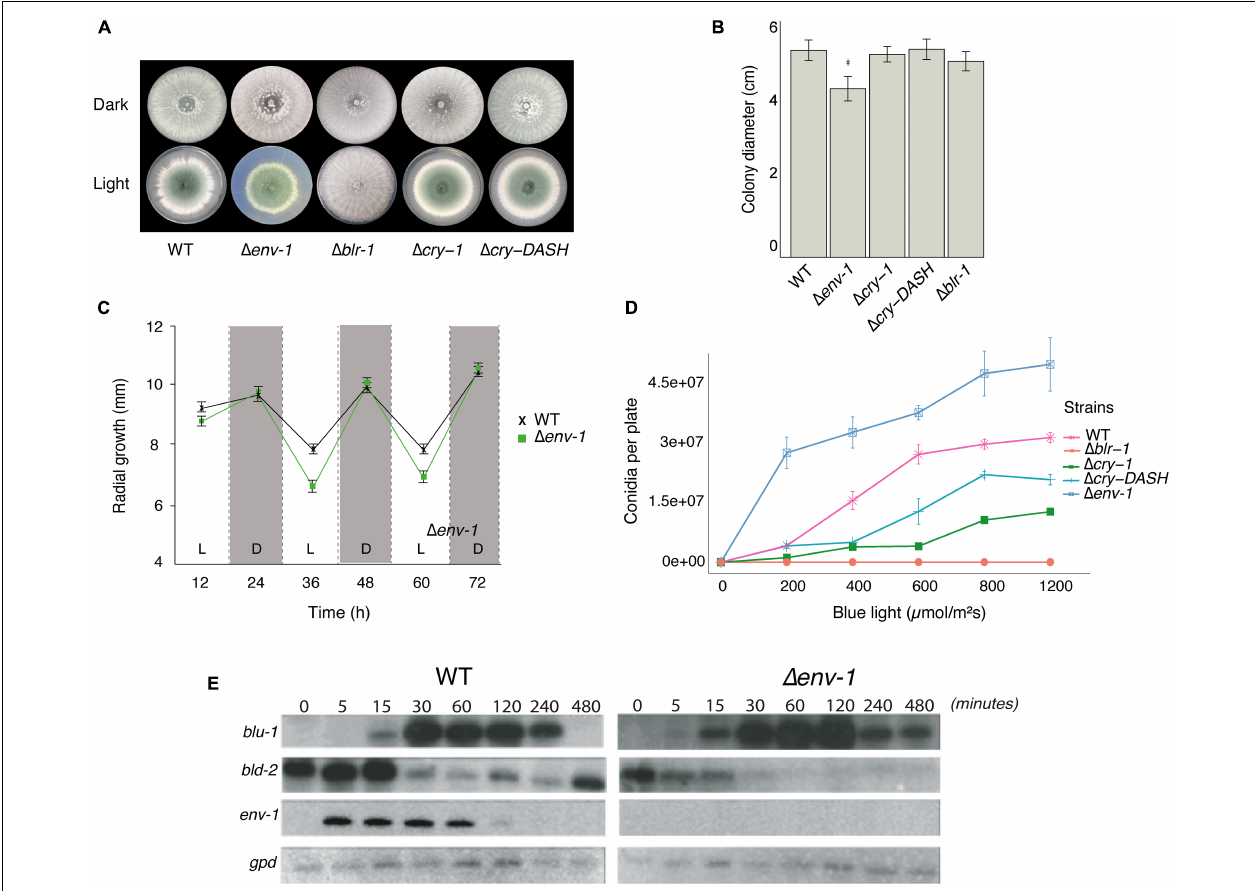
FIGURE 1 | Effect of light on growth and conidiation in the WT strain and the mutants (cid:49) blr -1, (cid:49) cry -1, (cid:49) cry-DASH and (cid:49) env -1. (A) Phenotype of the strains growing under darkness and constant light exposure. (B) Total growth of colonies under constant light exposure. Growth was measured every 12 h for 72 h under constant light and darkness on potato dextrose agar (PDA). (C) Radial growth of the WT and (cid:49) env -1 strains under 12-h light/dark cycles with 2.9 µ mol · m - 2 · s - 1 of blue light. (D) Production of conidia at different fluencies of blue light. The strains were grown for 36 h in the dark, then exposed to a pulse of blue light of 0, 200, 400, 600, 800, and 1,200 µ mol · m − 2 . Bars show means ± SEM. (E) Expression of the blu -1, bld -2 and env -1 genes under constant illumination (5 µ mol.m − 2 s − 1 ) at times 5, 15, 30, 60, 120, 240, and 480 min. Asterisks indicate statistically significant differences ( P < 0.05; n = 8). A simple ANOVA analysis was used for each condition.